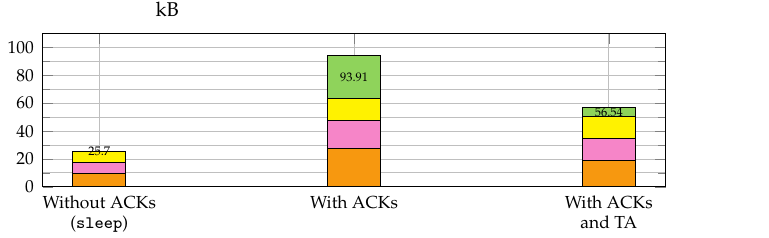
Figure 9. Comparison of Acknowledge Traffic from Device to MQTT Broker for the Slice Size of 220 Bytes (Total of 399 Slices) with and without Topic Alias (TA) in